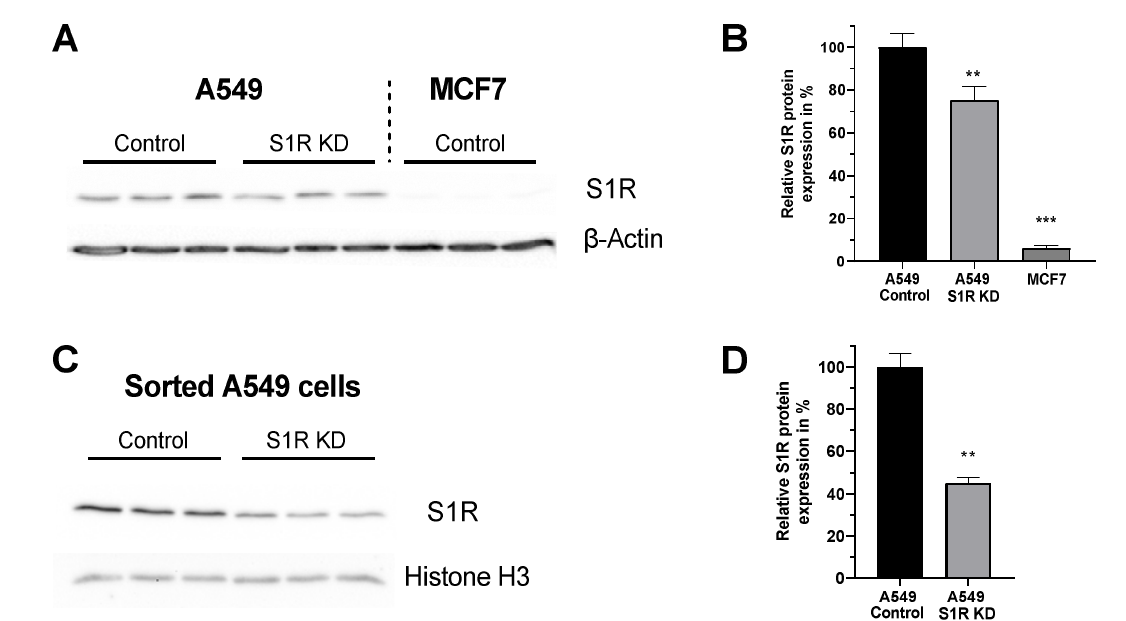
Figure 1. Expression level of S1R in A549 and MCF-7 Cells. ( A ) Immunoblot images show the expression level of S1R in cells transfected either with control siRNA or siRNA against S1R (left) in A549 cells and non-transfected MCF7 cells (right). ( B ) Bar graphs represent immunoblot analysis of S1R expression as MEAN ± SEM in A549 cells transfected with control siRNA or siRNA against S1R and non-transfected MCF7 cells. ( C ) Immunoblot images show the expression level of S1R in cells transfected either with control siRNA or siRNA against S1R in sorted, transfection positive A549 cells. ( D ) Bar graphs represent immunoblot analysis of S1R expression as MEAN ± SEM in sorted A549 cells. Significant differences were assessed using one-way ANOVA with Tukey’s multiple comparison test (for B ) or unpaired t-test (for D ) and presented as (** p < 0.01, *** p < 0.001). A549 cells: A549 Control ( n = 3), A549 S1R KD ( n = 3), MCF7: ( n = 3), sorted A549 Control ( n = 3), sorted A549 S1R KD ( n = 3).